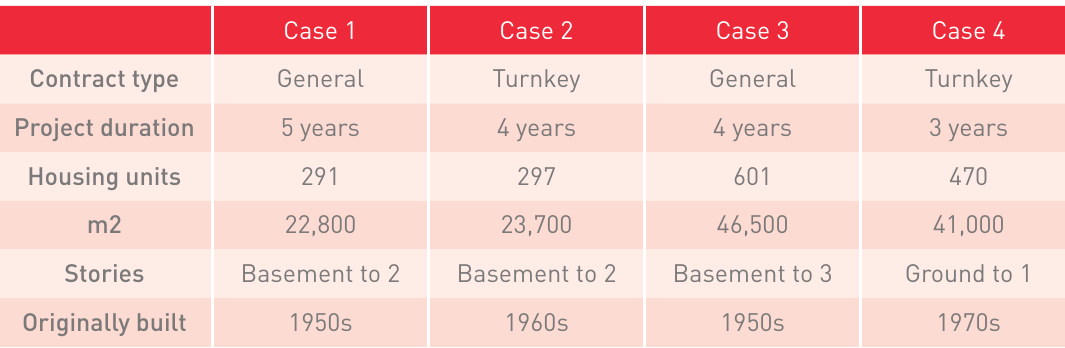
Characterization of the four